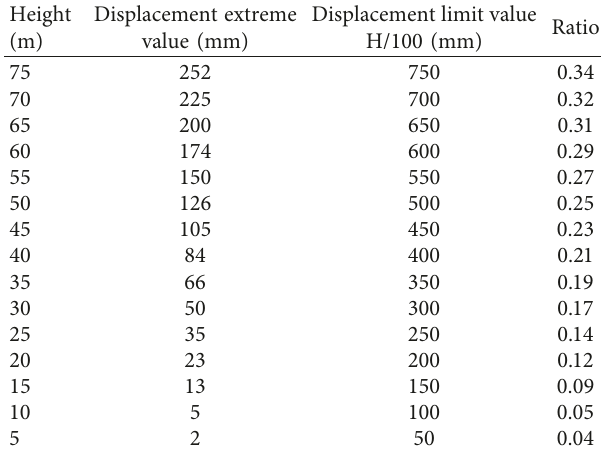
Table 1: Maximum values of horizontal earthquake influence coefficients for several seismic intensities.